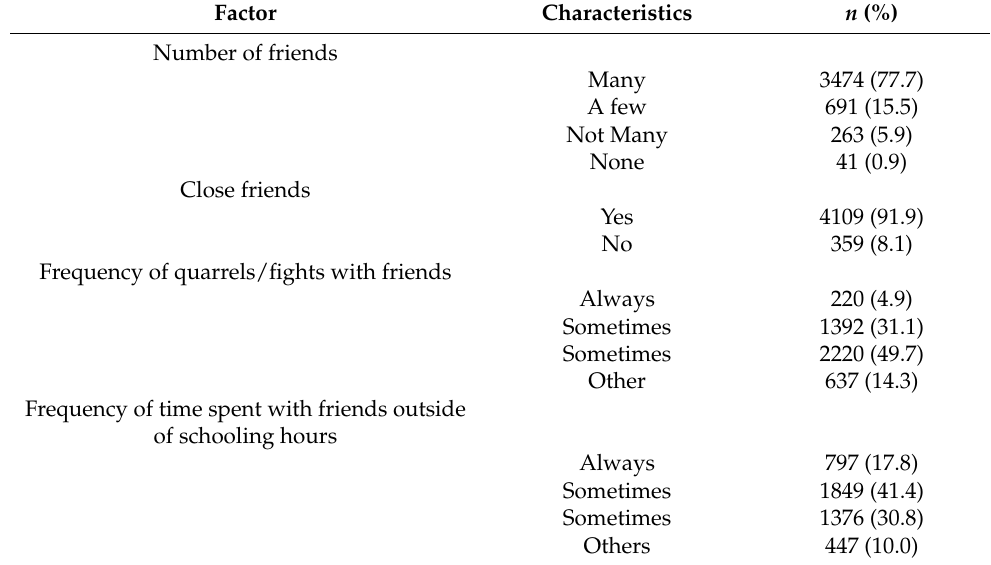
Table 2. Distribution of peer factors ( n = 4469).